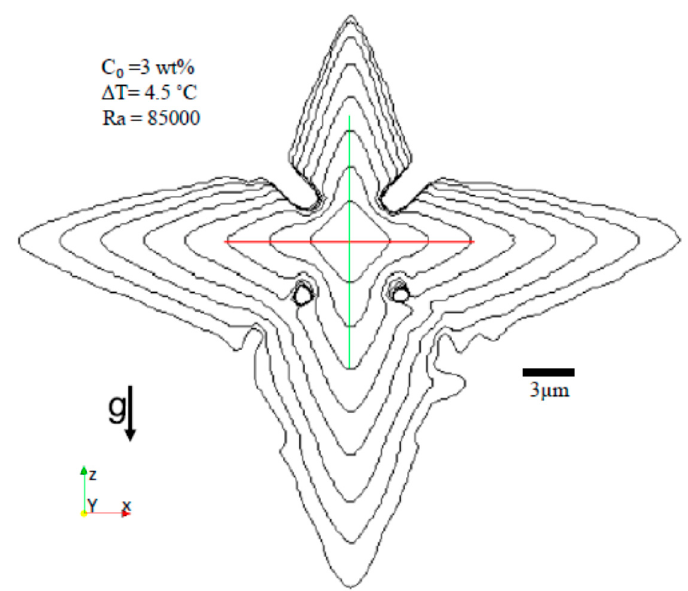
Figure 17. 2D sections showing the morphological changes of the 3D dendrite growing under natural convection. Snapshots were taken after 0.80 ms, 1.60 ms, 2.40 ms, 3.20 ms, 4.00 ms, 4.80 ms, 5.60 ms, and 6.40 ms of simulated time, starting from the innermost to the outermost contour.